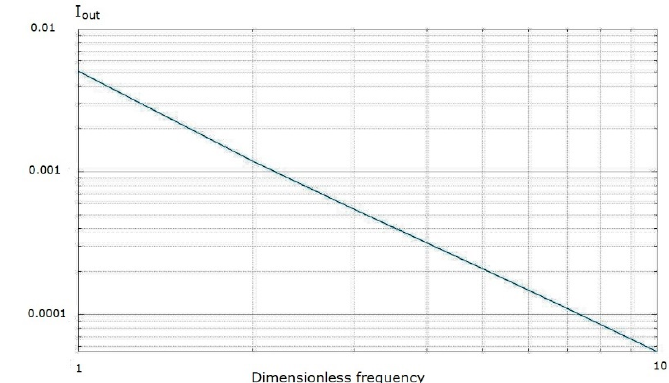
Figure 10. Dependence of ( a ) stationary background current and ( b ) signal current on the dimen- sionless distance between cathodes.